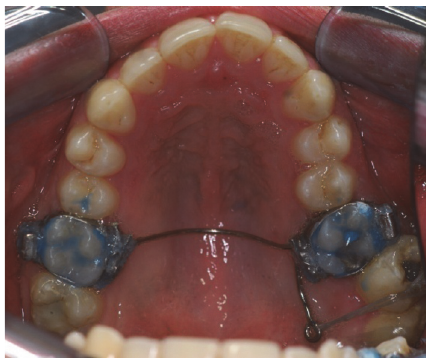
Figure 4: Palatal arch with extension